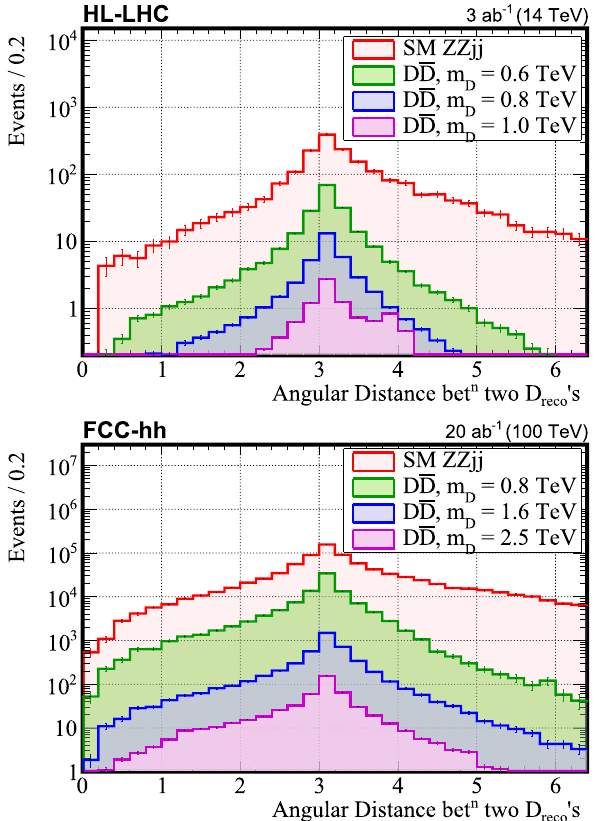
Fig. 6 Distributionof χ 2 valuesobtainedafterminimizationforHL- DD LHC (top) and FCC-hh (bottom)